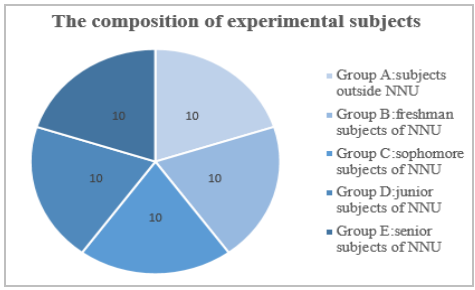
Figure 2. Experimental subjects